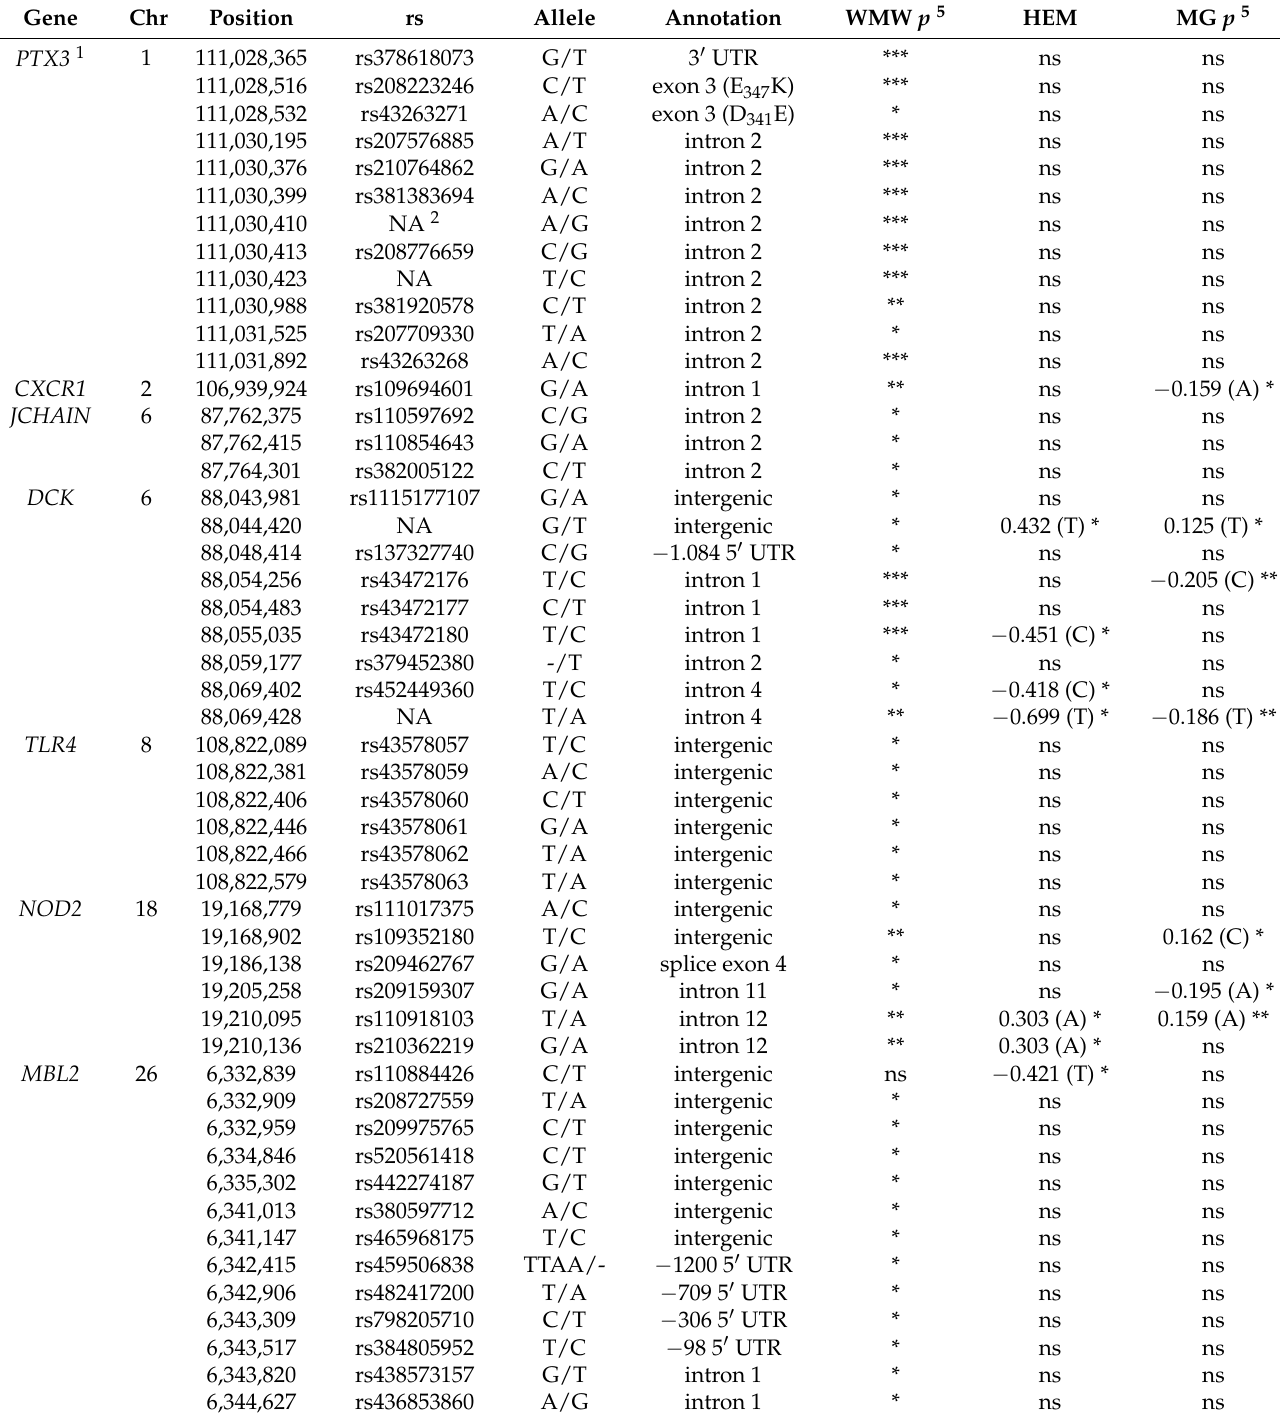
Table 2. SNPs resulted significantly different in frequency in the two tail of the deregressed EBVs for SCS as calculated with Wilcoxon-Mann-Whitney (WMW) test. The SNP resulted significantly associated with the phenotype with the Heteroscedastic Effects regression Mode (HEM) and the multiple gene approach (MG) are also reported together with the SNP